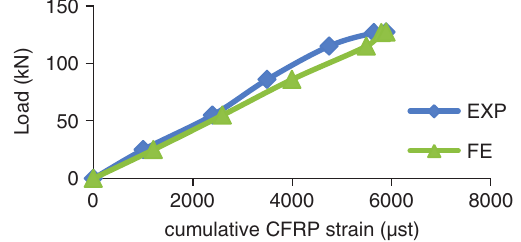
Fig. 24. Load against the cumulative CFRP strain for the post- repair phase of the beam